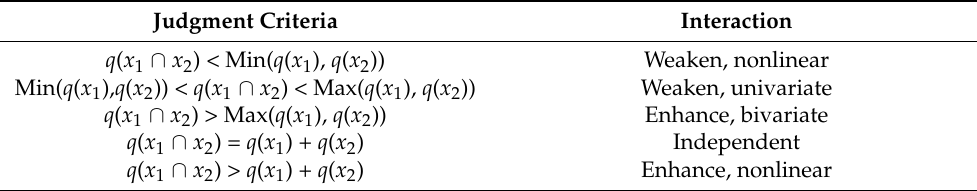
Table 3. The patterns of interaction detector.